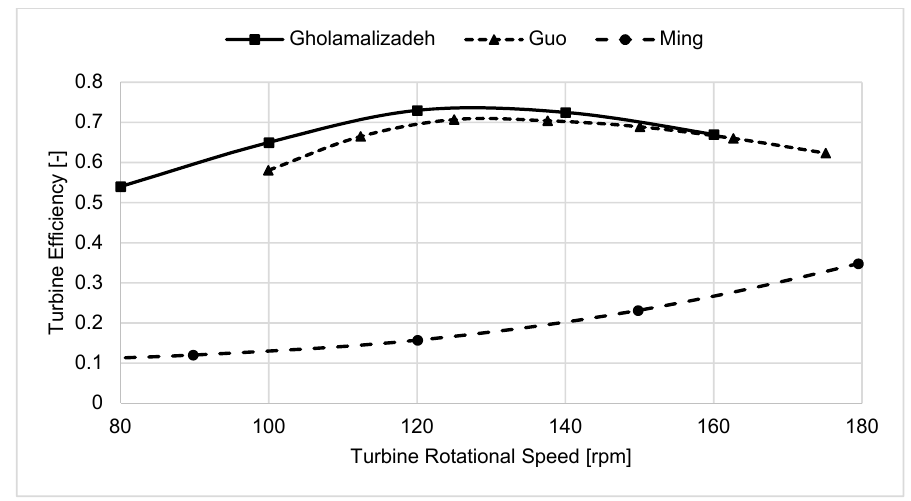
Figure 5. Turbine efficiency at different turbine rotational speeds.